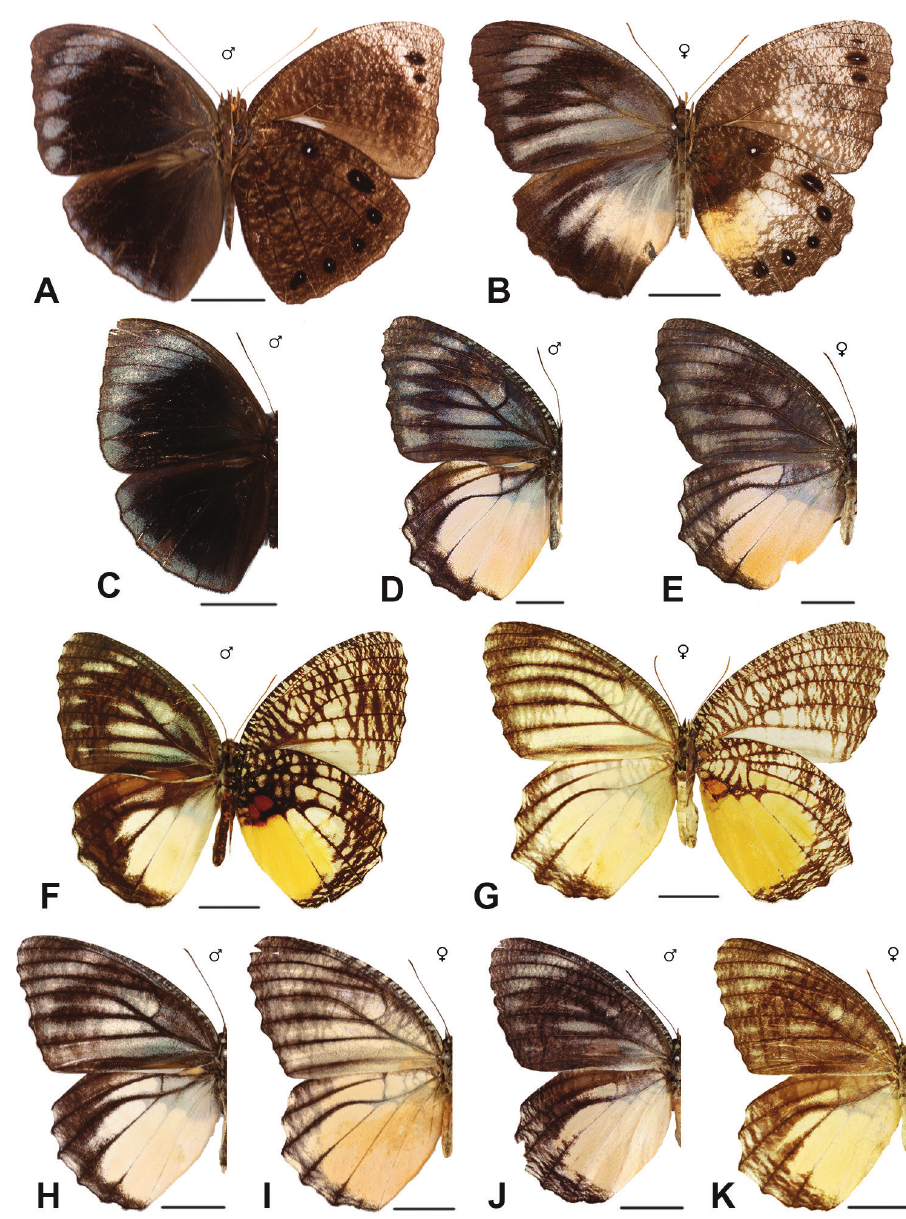
Figure 2. A esaca leontina ♂ D+V NHM Indonesia: North Sumatra, Nias B esaca leontina ♀ D+V NHM Indonesia: North Sumatra, Nias C esaca esaca ♂ D KUTH Thailand: Yala, Than To D